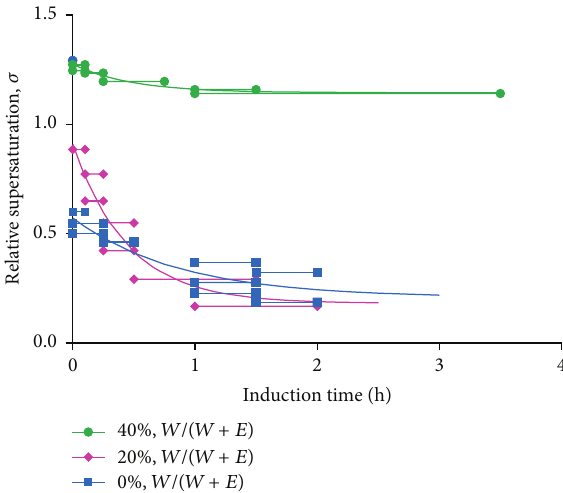
Figure 9: PNT in water-ethanol mixtures at 15 ∘ C. The best fit exponential curve is drawn for each concentration.